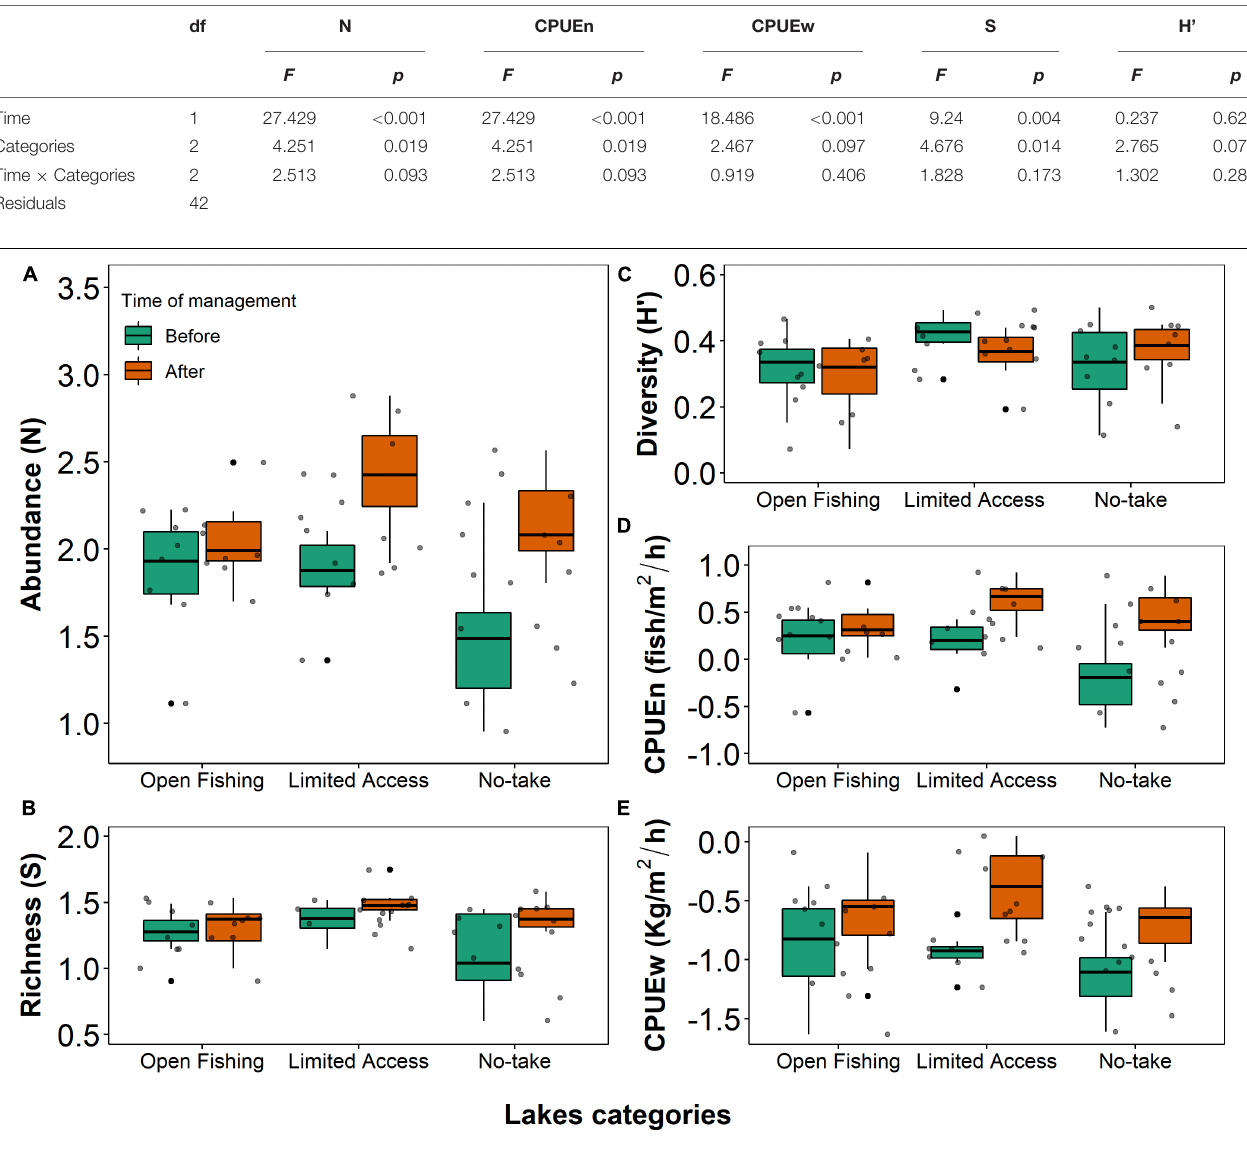
FIGURE 3 | Boxplots of the comparison between sampling events completed before (BM) and after co-management implementation (AM), performed in lakes of distinct categories of management, using overall (A) numeric abundance (BM: Open fishing = 89 ± 50.41; Limited access = 79 ± 34.08; No-take = 49 ± 58.08; AF: Open fishing = 128 ± 82.85; Limited access = 341 ± 236; No-take = 165 ± 106.49), (B) species richness (BM: Open fishing = 19.62 ± 7.28; Limited access = 24 ± 6.39; No-take = 15.25 ± 10.06; AF: Open fishing = 22.25 ± 8.32; Limited access = 32.62 ± 10.05; No-take = 25.12 ± 6.40), (C) Shannon’s diversity index (BM: Open fishing = 2.13 ± 0.47; Limited access = 2.31 ± 0.37; No-take = 2.19 ± 0.65; AF: Open fishing = 2 ± 0.48; Limited access = 2.64 ± 0.39; No-take = 2.38 ± 0.40), (D) CPUEn (BM: Open fishing = 1.85 ± 1.05; Limited access = 1.65 ± 0.71; No-take = 1.02 ± 1.21; AF: Open fishing = 2.67 ± 1.72; Limited access = 7.10 ± 4.91; No-take = 3.44 ± 2.21), and (E) CPUEw (BM: Open fishing = 0.17 ± 0.13; Limited access = 0.12 ± 0.05; No-take = 0.09 ± 0.07; AF: Open fishing = 0.29 ± 0.23; Limited access = 0.51 ± 0.35; No-take = 0.22 ± 0.10) as response variables. The black line is the median, black points